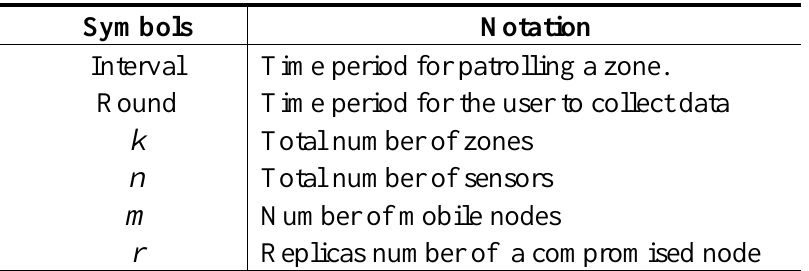
Table 1. Some Notations used in this